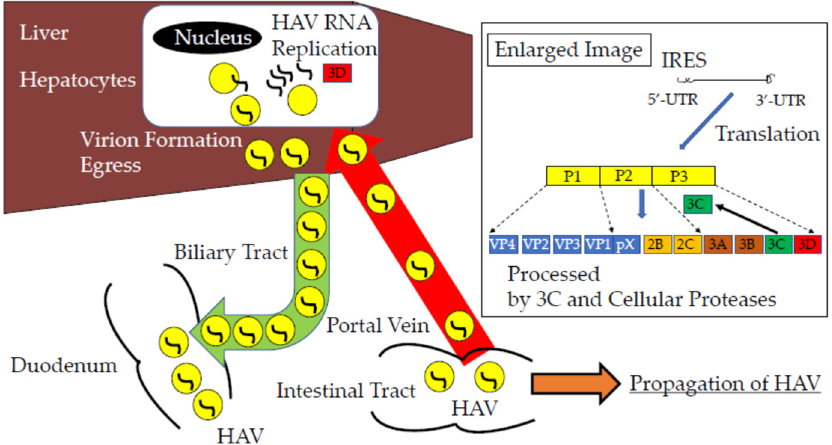
Figure 1. Hepatitis A virus (HAV) infection into hepatocytes of the liver. HAV internal ribosomal entry-site (IRES), 3C protease, and 3D ribonucleic acid (RNA)-dependent RNA polymerase are at- tractive targets of anti-HAV drugs [11]. HAV 5 ′ -untranslated region (UTR) has conservative RNA sequences among different strains [8,12].